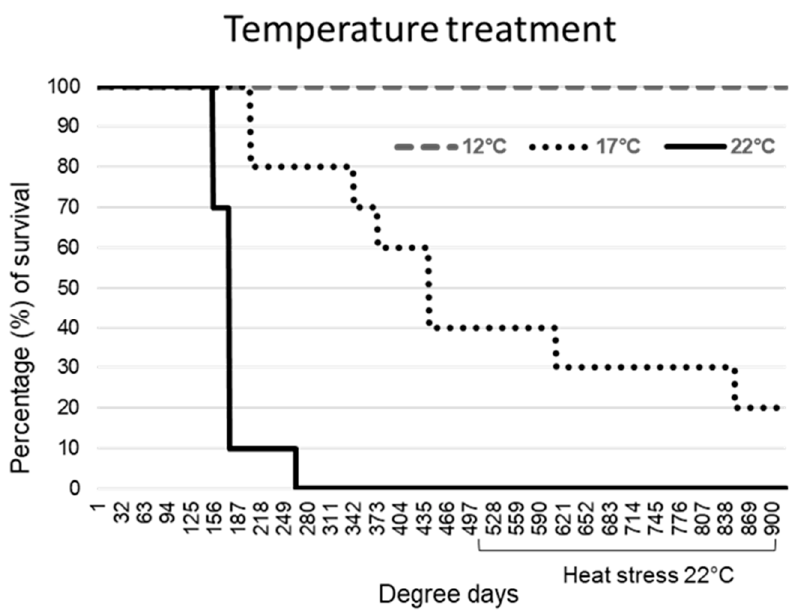
Figure 1. Survival curve of common carp infected with koi herpesvirus (KHV) at 12 ◦ C, 17 ◦ C or 22 ◦ C. At ~500 degree days (29 days for fish at 17 ◦ C and 42 days at 12 ◦ C), all survivors were subjected to temperature raise to 22 ◦ C. n = 10 per group.